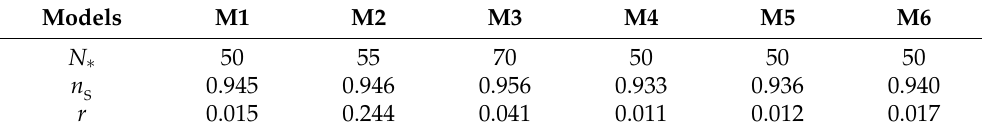
Figure 3. The scalar power spectrum dashed lines) that arise in the models M1 to M6 have been plotted for the parameters and initial conditions that we have discussed. As expected, all the scalar power spectra exhibit a strong peak on small scales due to the epoch of ultra slow roll inflation that occurs in these models. Table 1. The scalar spectral index n = 0.05Mpc − 1 , are tabulated for the models M1 to M6. We have also listed the values of N k ∗ different models that we have worked with to achieve the n from the case of M3, the other models lead to n